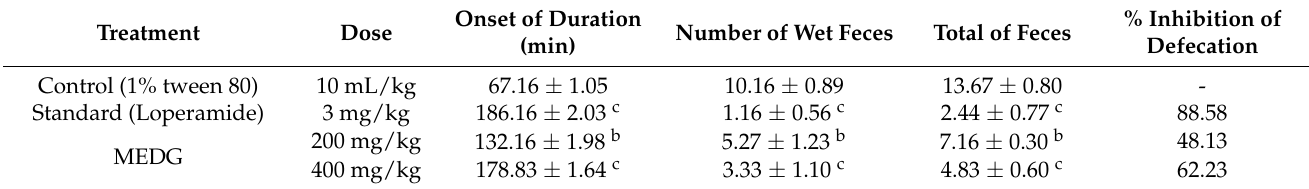
Table 2. Effects of MEDG on castor oil-induced diarrhea in mice.